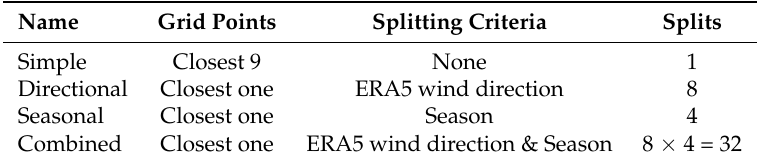
Table 2. Summary of the distinctive properties of the QM (Quantile Mapping) calibrations performed. Name Grid Points Splitting Criteria Splits Simple Closest 9 None 1 Directional Closest one ERA5 wind direction 8 Seasonal Closest one Season 4 Combined Closest one ERA5 wind direction &